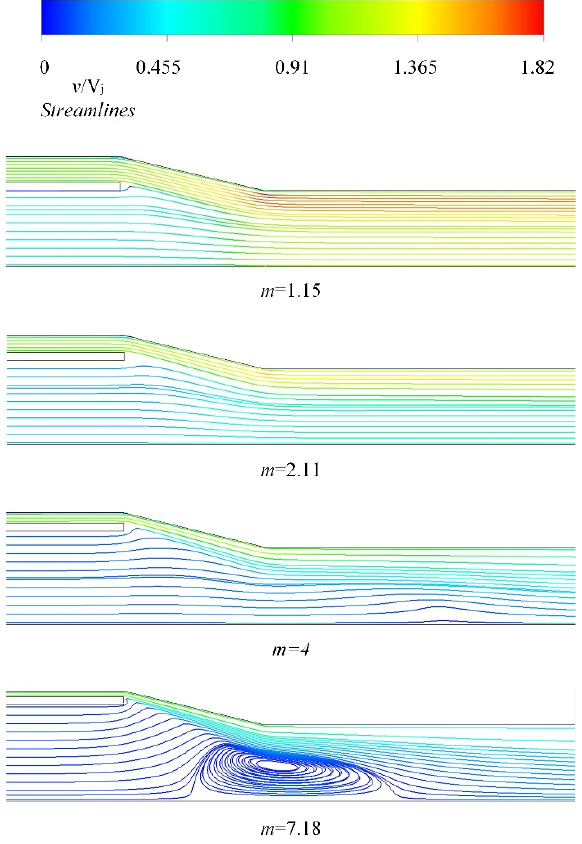
Figure 9. Streamlines from the suction chamber to the inlet of throat.